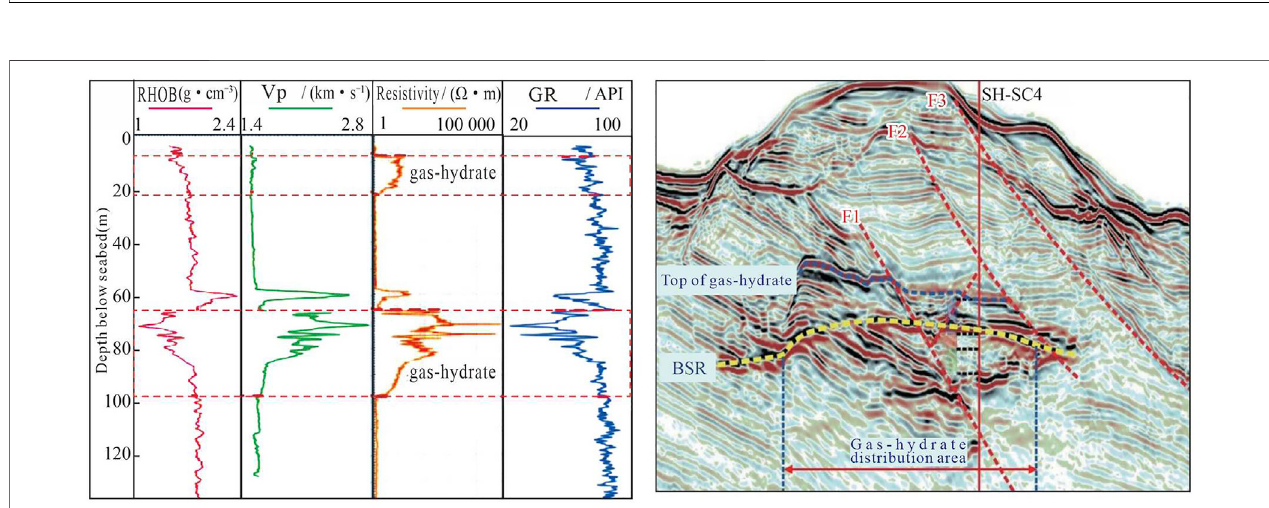
FIGURE 7 | Geophysical response of hydrate reservoirs in the Shenhu Area in the South China Sea (Modi fi ed after Li et al., 2018; Ning et al., 2020).